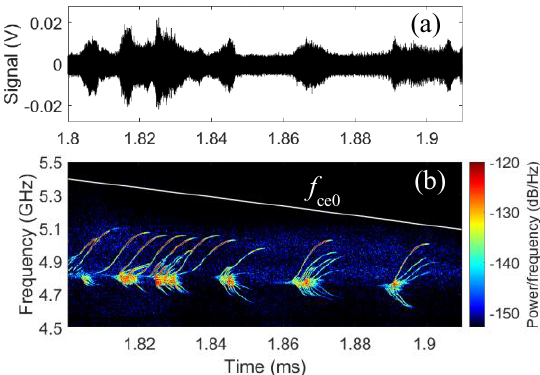
Fig. 1. ( a ) Waveform of the wave electric field oscillations and ( b ) its spectrogram. The white line shows the value of electron cyclotron frequency in the trap center on the axis. The ECR heat- ing is operating during 0 – 1 ms (not shown). Adopted from [1]